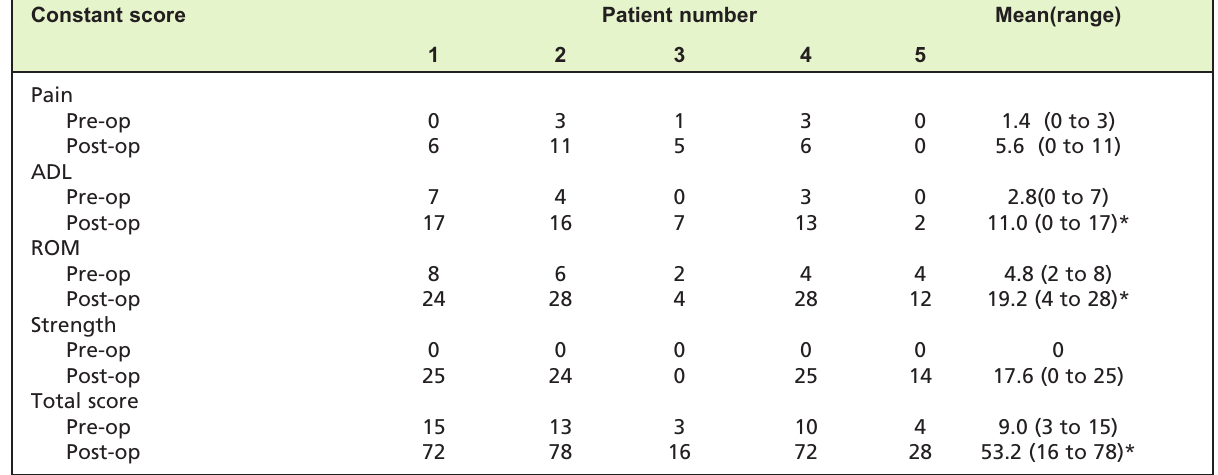
Pre-operative and post-operative functional shoulder Table I: